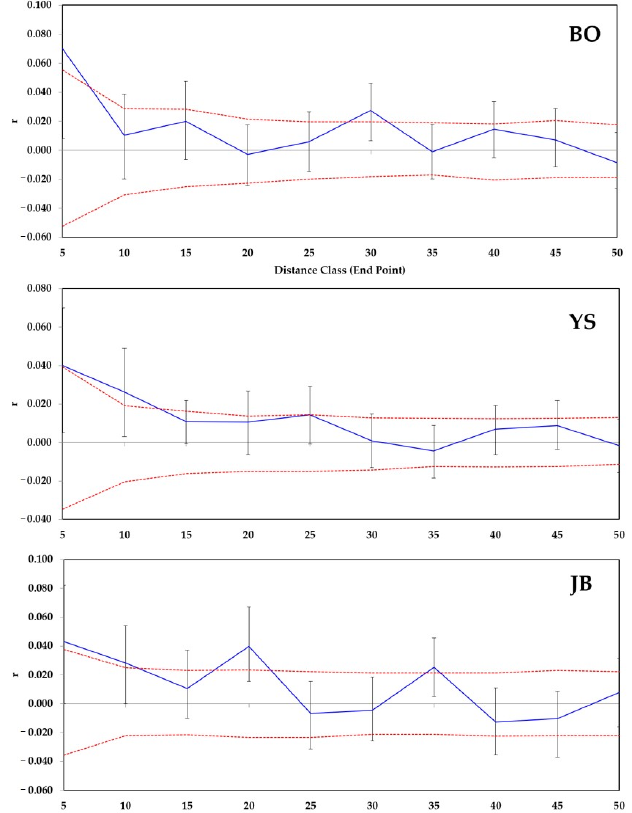
Figure 4. Distogram for Abies koreana based on Tanimoto genetic distance using 10 nuclear simple- sequence repeat (nSSR) markers. The r value is an autocorrelation coefficient. The solid line represents the correlation between genetic distance and geographic distance. The dotted lines are 95% confidence intervals. BO, Bangaeorum; YS, Yeongsil; JB, Jindallaebat.